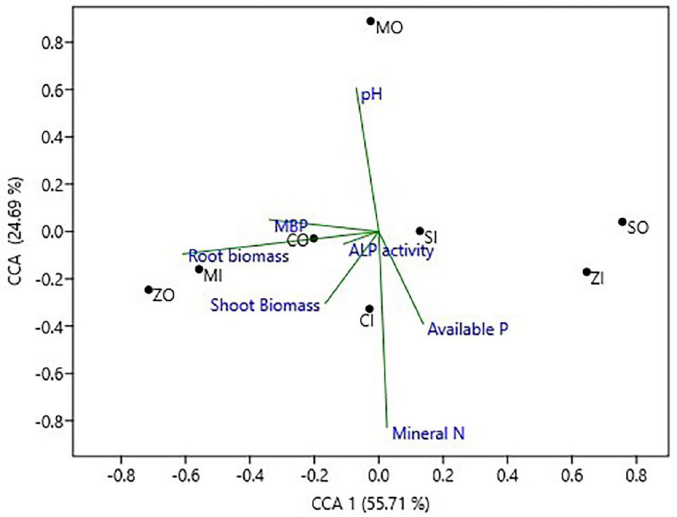
Figure 3. Ordination plot of CCA (Canonical Correspondence Analysis) to exhibit the correlation between soil variables and phoD encoding community structure. CO, chickpea organic farming; CI, chickpea conventional farming; MO, mustard organic farming; MI, mustard conventional farming; SO, soybean organic farming; SI, soybean conventional farming; ZO, maize organic farming; ZI, maize conventional farming; MBP, microbial biomass